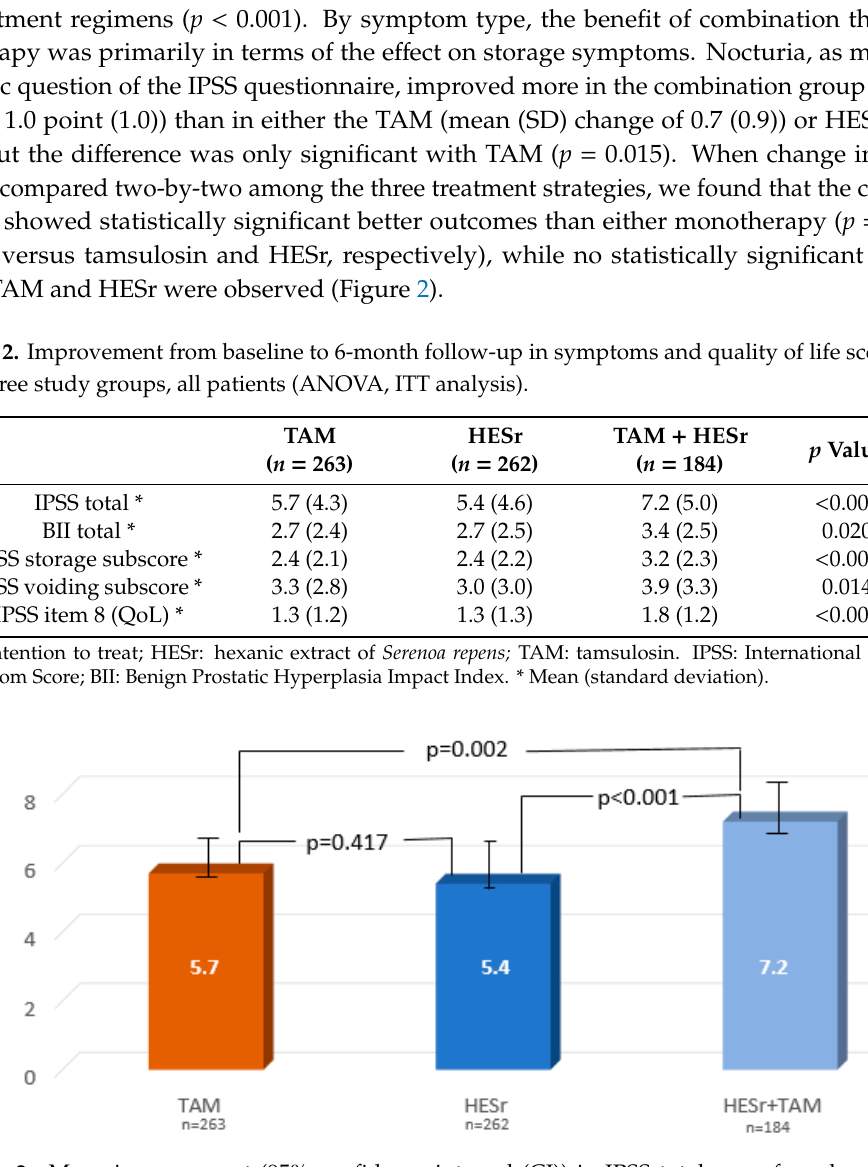
Figure 2. Mean improvement (95% confidence interval (CI)) in IPSS total score from baseline to 6 months for the three treatment groups (paired comparisons between the 3 groups, ITT analysis). IPSS: International Prostate Symptom Score; TAM: tamsulosin; HESr: hexanic extract of Serenoa repens . Student’s t -test.